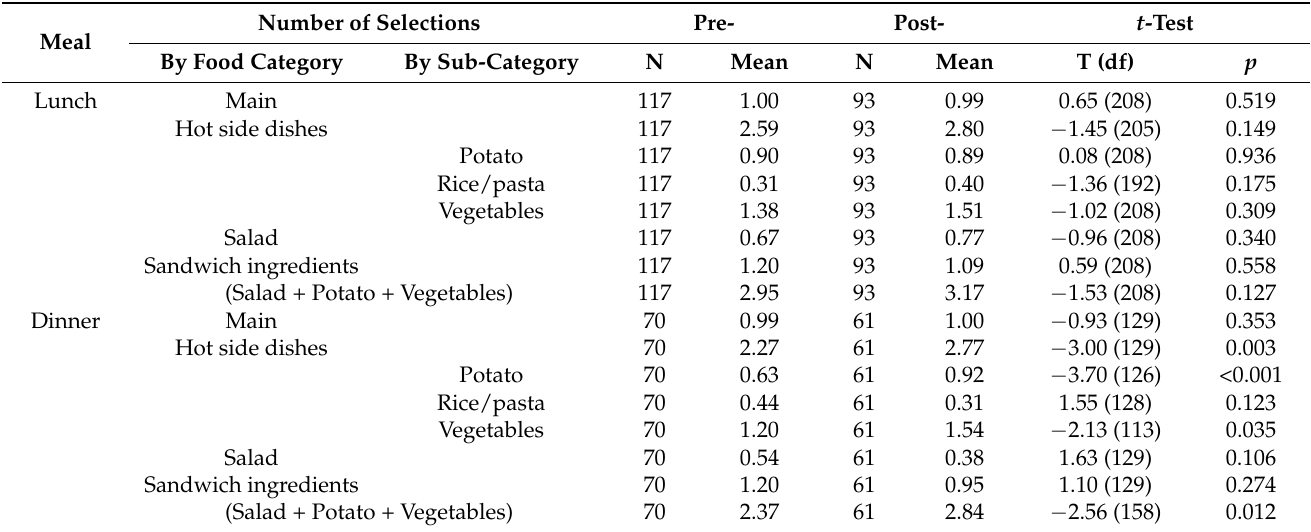
Table 4. Selections from each food category: pre- and post-communication (pre n = 190; post n = 159 meal photos) 1 . Meal